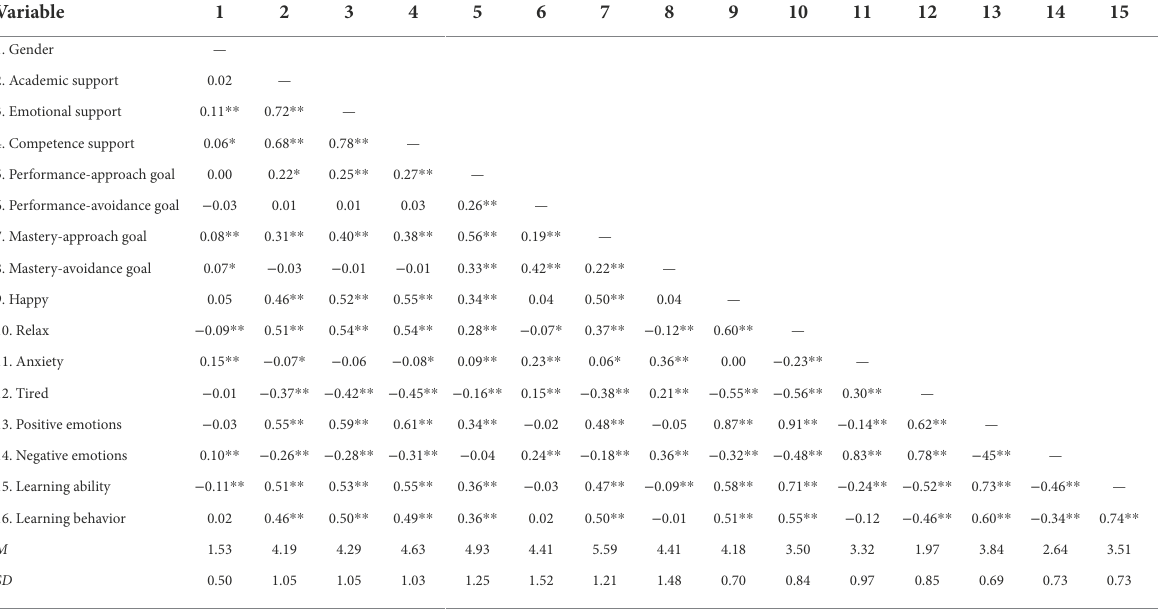
TABLE 1 Means, standardized deviation, and correlations for all variables.